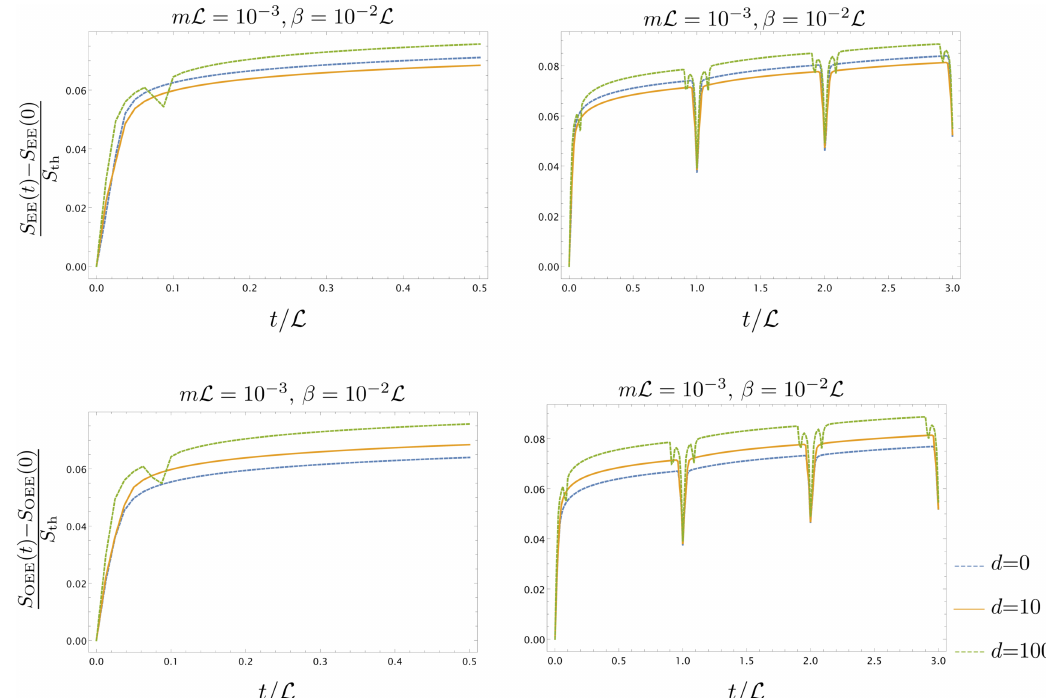
Figure 5 . Disjoint intervals: time dependence of S EE and S OEE in free massless scalar theory, for various distances between entangling regions and various times. We take N =1501 , N + N =20+31 . Their effective evolution is the same in different times. One can see N A A L 2( R 2) L 1( R 1) also the memory